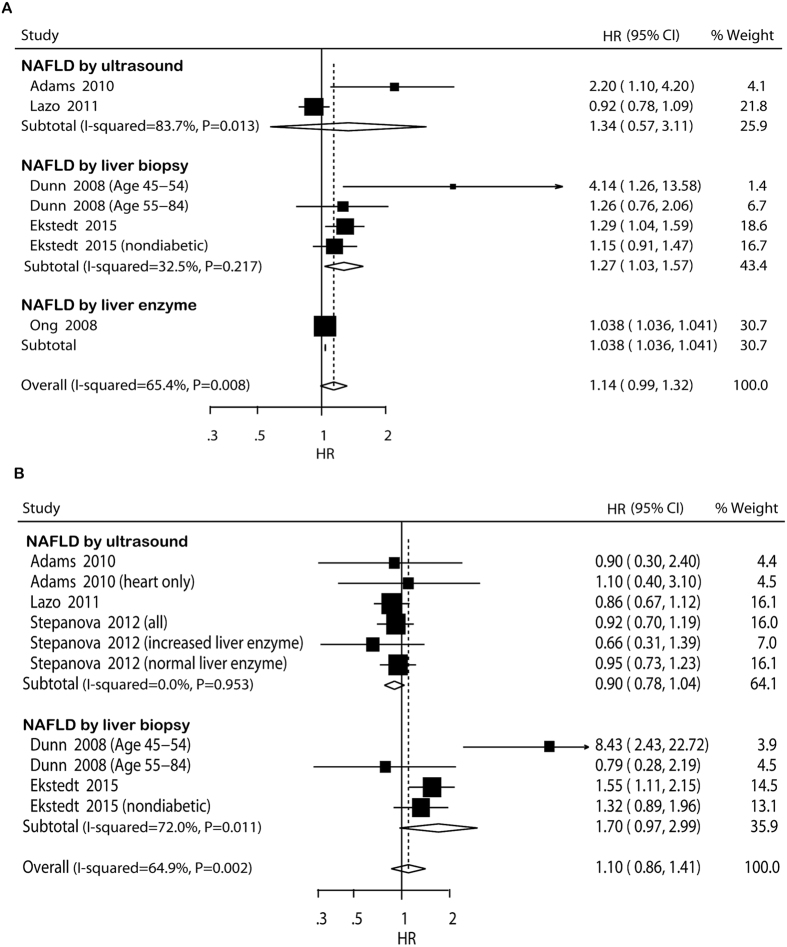
Forest plot of comparison.NAFLD versus non-NAFLD, outcome: overall mortality (A) and cardiovascular disease mortality (B) based on cohort studies. Studies assessing NAFLD by ultrasound, liver biopsy or liver enzyme were considered separately.